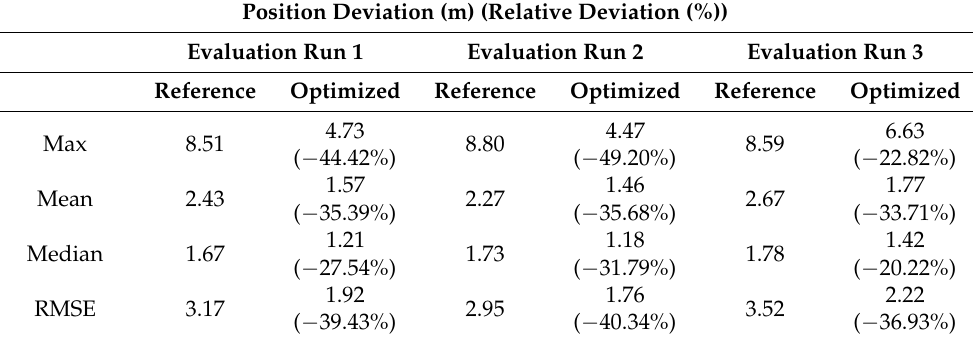
Table 3. Characteristics of the Samsung Galaxy S7 evaluation runs.